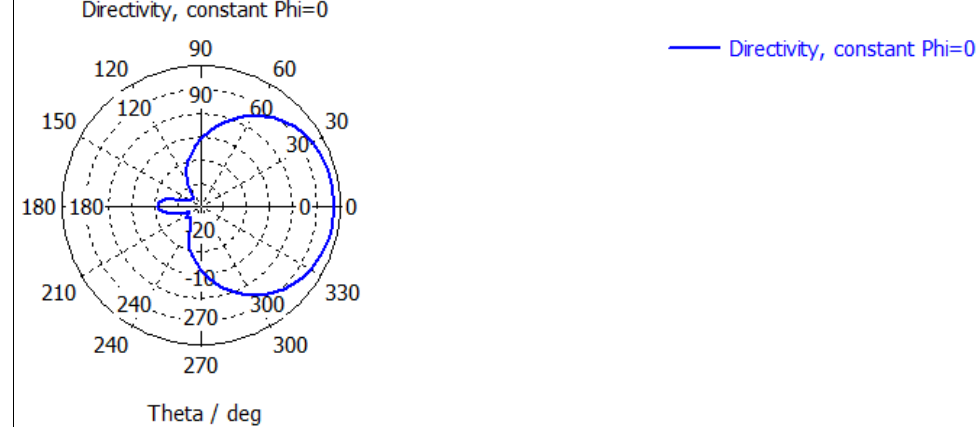
Figure 9. Radiation Pattern Front Lobe